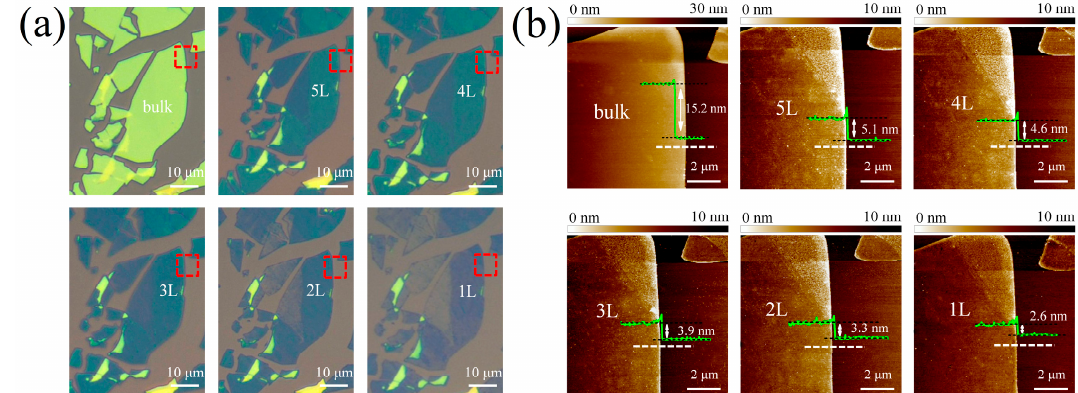
Figure 6. ( a ) Optical images of large-area MoTe 2 flakes before and after thinned from bulk to 5L, 4L, 3L, 2L and 1L MoTe 2 . ( b ) The corresponding AFM images of the selected square regions in (a), with superimposed height profiles along the dashed lines.